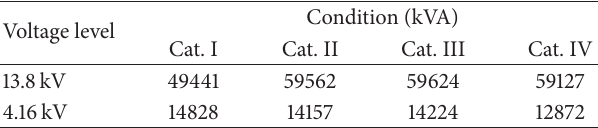
Table 5: Apparent power rating (kVA) loading summary only for non-Class 1E